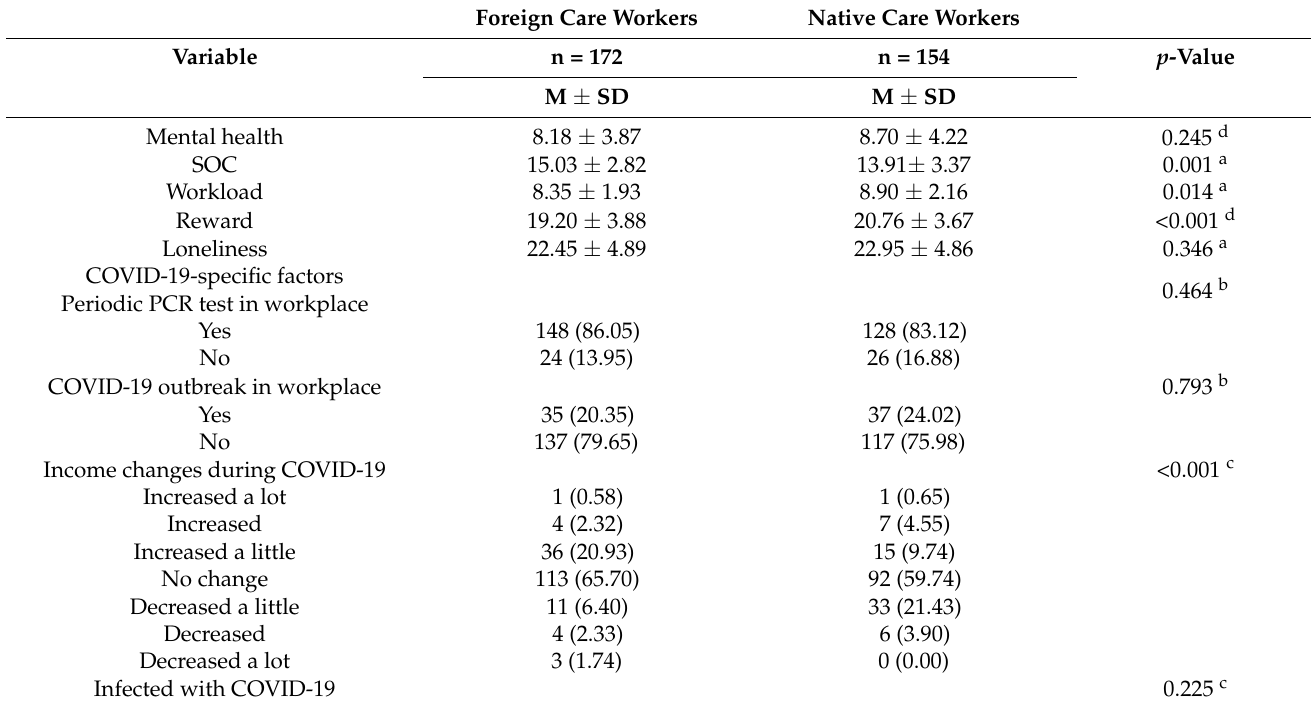
Table 2. Average scores of variables in foreign care workers and native care workers. Foreign Care